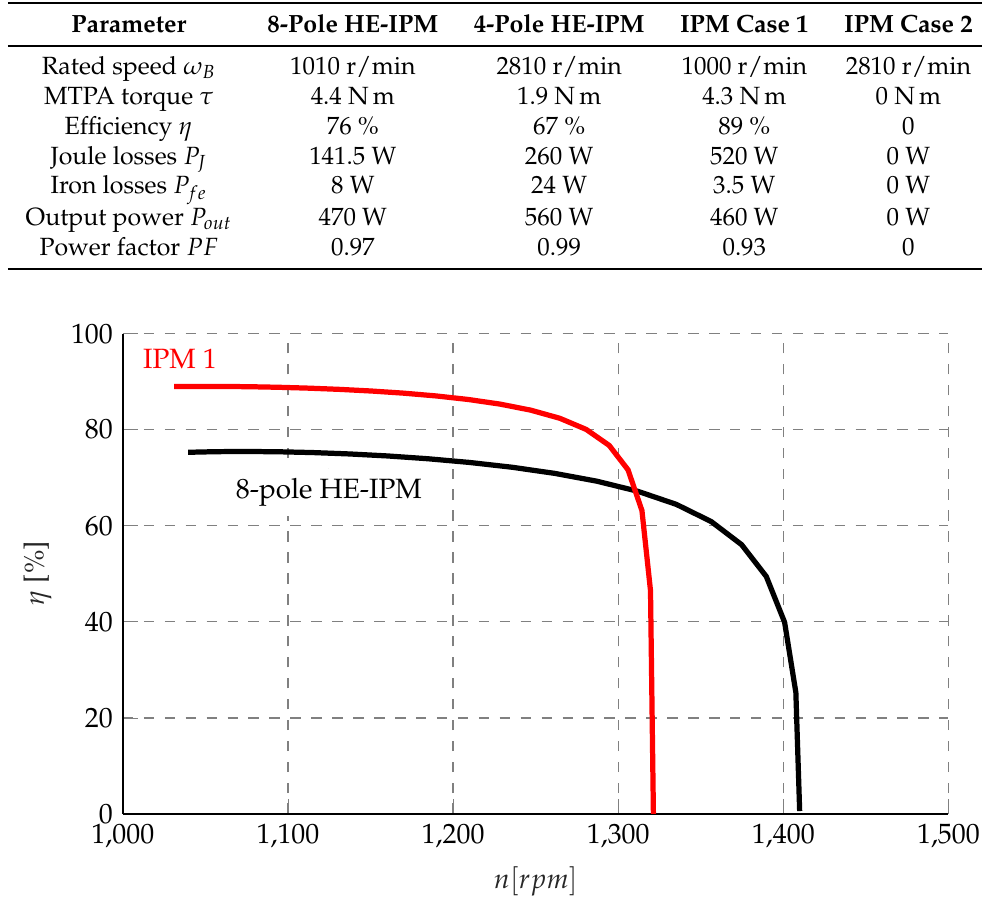
Figure 24. Motor efficiency during flux weakening: a comparison between HE-IPM and IPM.